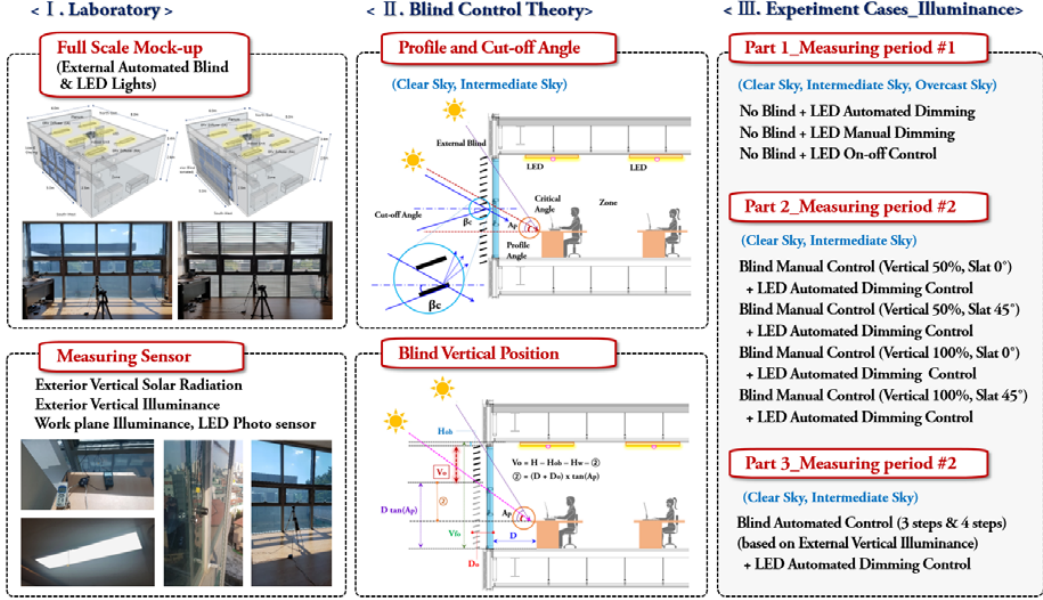
Figure 1. Flow diagram of the methods in this study.